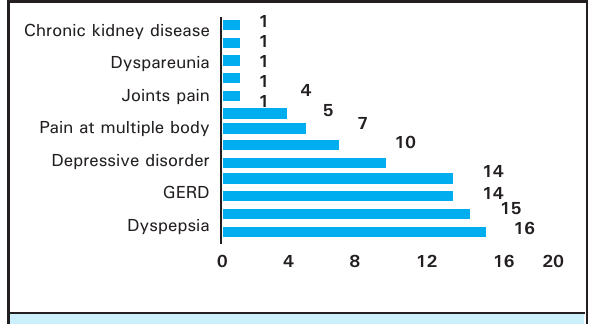
Figure 2. Co-morbidities in patients with IBS. *GERD-